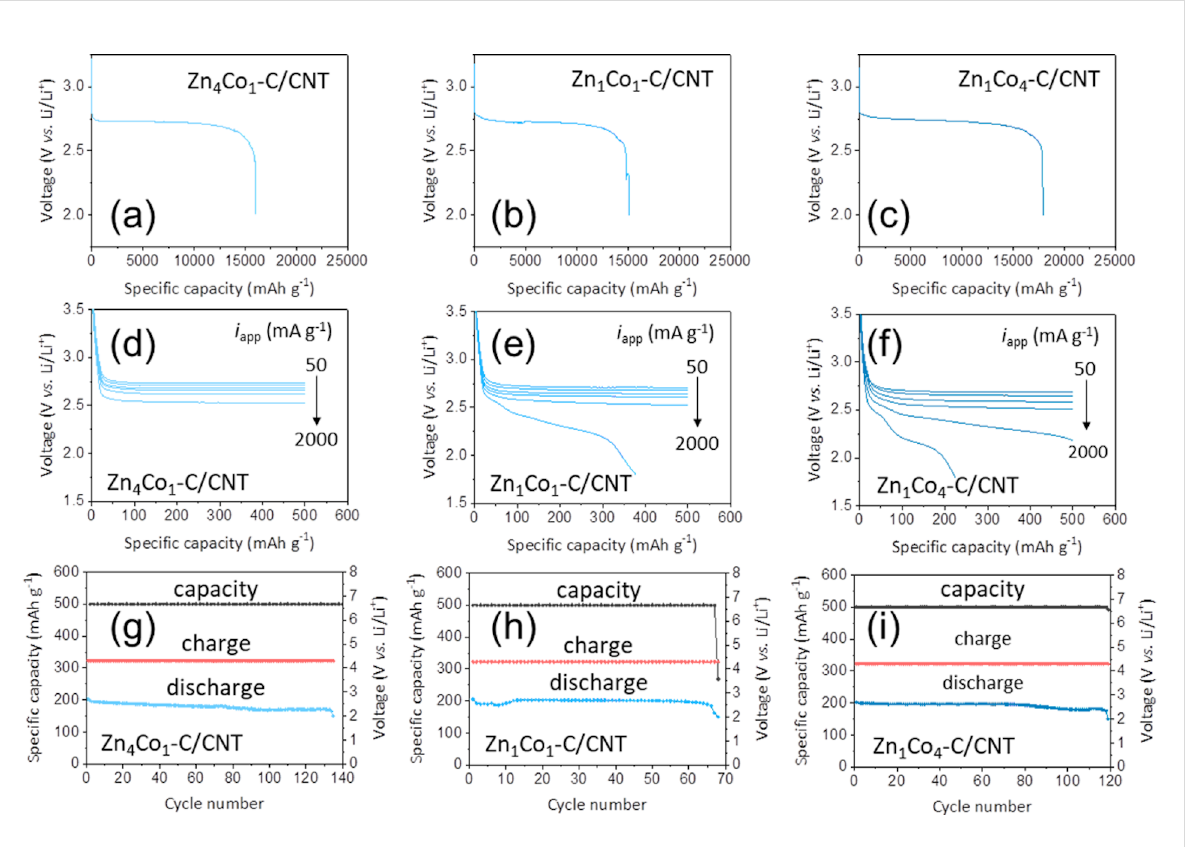
Figure 6: Galvanostatic discharge profiles (a, b, c) of the LOBs with (a) Zn 4 Co 1 –C/CNT, (b) Zn 1 Co 1 –C/CNT, and (c) Zn 1 Co 4 –C/CNT electrodes. The discharge measurements were performed in pure O 2 at a current density of 50 mA·g − 1 . Plots of discharge curves (d, e, f) of (d) Zn 4 Co 1 –C/CNT, (e) Zn 1 Co 1 –C/CNT, and (f) Zn 1 Co 4 –C/CNT electrodes. The cells were discharged in pure O 2 with a limited capacity of 500 mAh·g − 1 at various cur- rent densities in the range of 50–2,000 mA·g − 1 . The terminal discharge and charge potentials during cycling (g, h, i) measured on (g) Zn 4 Co 1 –C/CNT, (h) Zn 1 Co 1 –C/CNT, and (i) Zn 1 Co 4 –C/CNT electrodes. The measurements were performed in pure O 2 at a current density of 200 mA·g –1 with a cutoff capacity of 500 mAh·g − 1